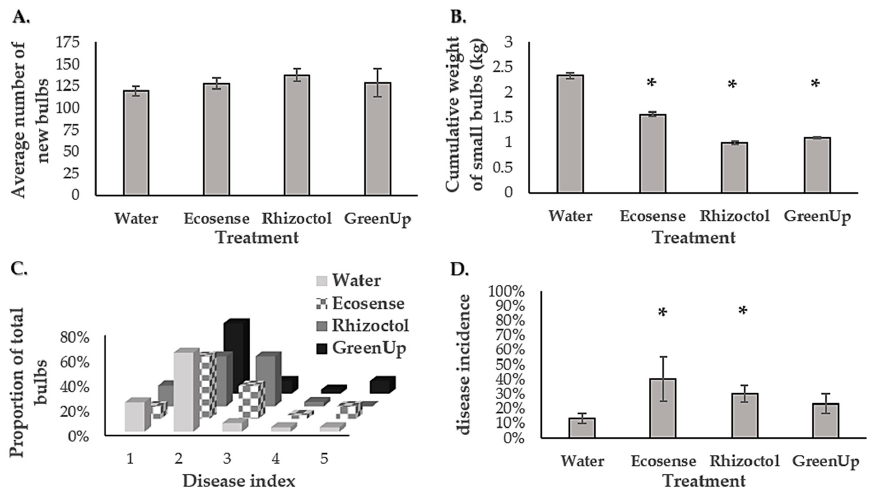
Figure 7. Propagation indices and damage from soft rot in Z. aethiopica tubers after the first growing season in perlite in the greenhouse. ( A ) Average number of new tubers formed during the season around the planted tubers in each treatment plot. ( B ) The cumulative weight of all small (less than 15 mm in diameter) tubers at the end of the growing season for all repeats in each treatment. ( C ) Severity of naturally occurring soft rot disease in tubers per treatment assessed using the following index: (1) completely healthy; (2) slightly soft; (3) stain of soft rot; (4) half of the bulb is rotten; and (5) completely rotten. ( D ) Average disease incidence for each treatment (3–5 in the disease index). Bars represent standard errors. An asterisk above the bar signifies a significant difference relative to the control treatment (Student’s t -test, p < 0.05).